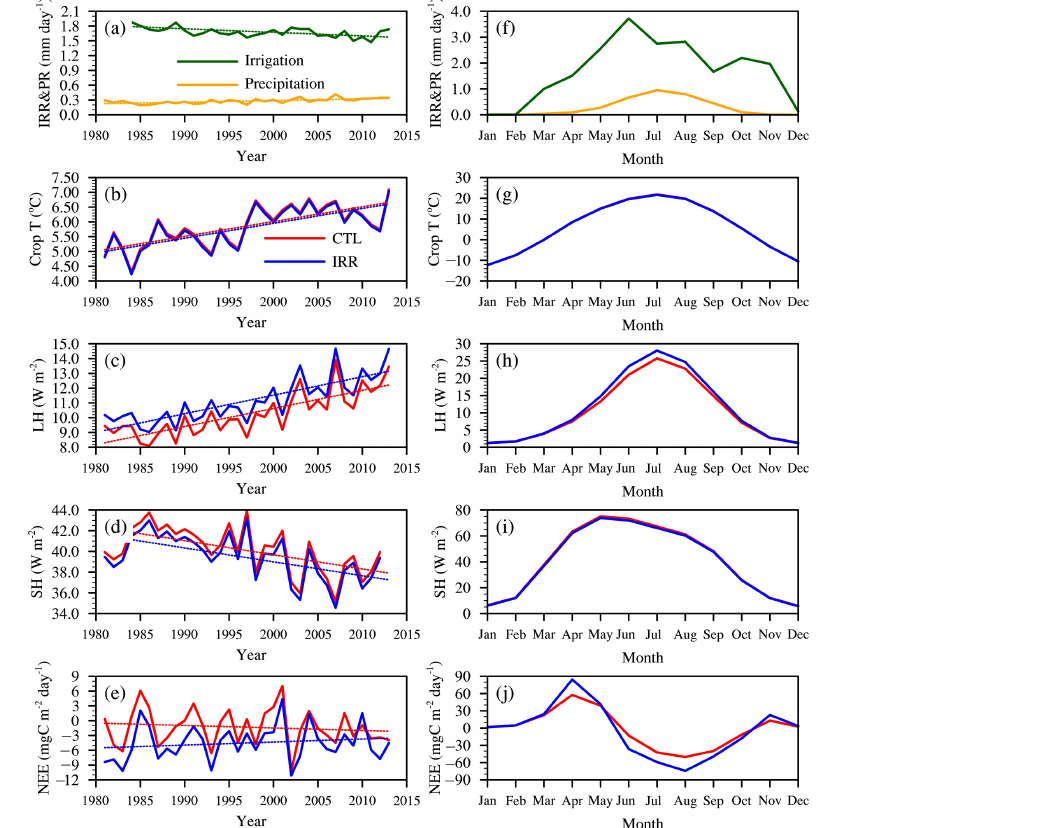
Figure 11. Time evolution plots of (a–e) annual and (f–j) seasonal (a, f) irrigation and precipitation, (b, g) crop temperature, (c, h) latent heat flux, (d, i) sensible heat flux, and (e, j) carbon heat flux, averaged over all crop grids of the Heihe River